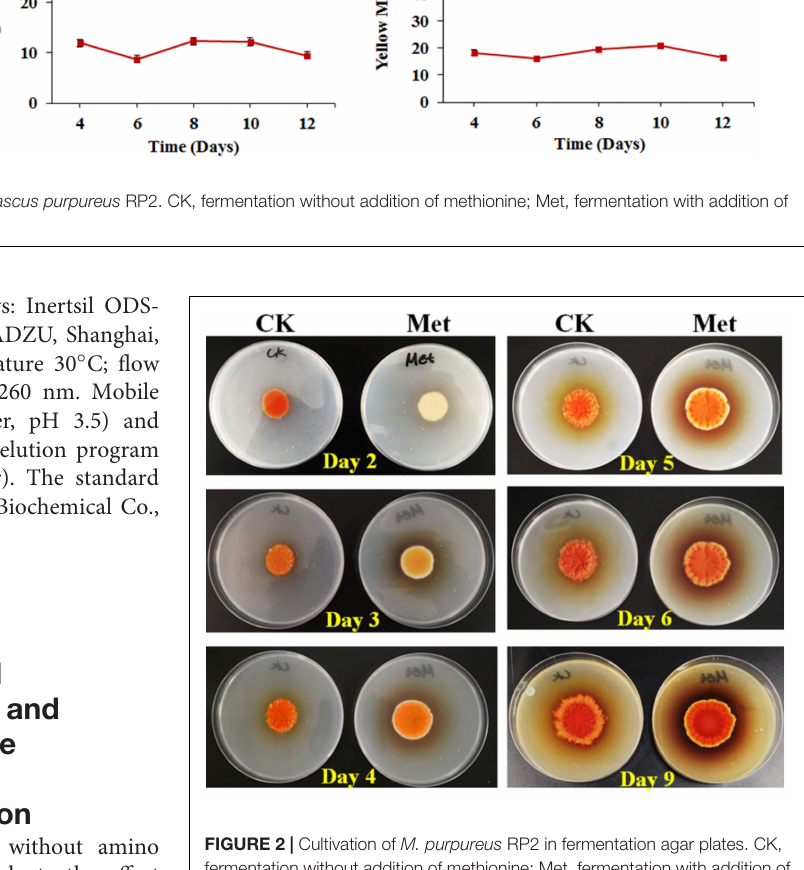
FIGURE 2 | Cultivation of M. purpureus RP2 in fermentation agar plates. CK, fermentation without addition of methionine; Met, fermentation with addition of 3 g/L